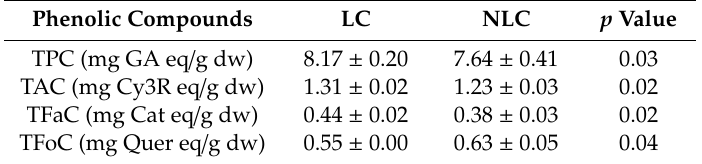
Table 2. Phenolic profiles of local sweet cherry (LC) and non-local sweet cherry (NLC).